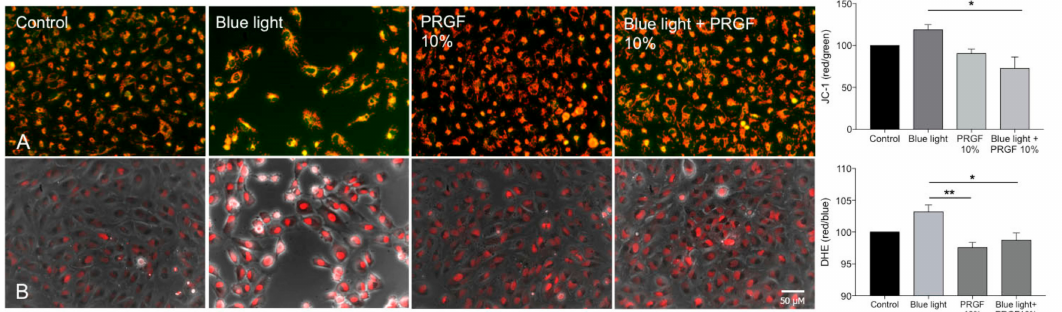
Figure 2. ARPE19 cell cultures ( n = 4). ( A ) JC-1 staining to study mitochondria status, PRGF enhances mitochondria status in presence of blue light; ( B ) Dihydroethidium staining (DHE) for the presence of reactive oxygen species (ROS), PRGF significantly reduces the expression of ROS as compared with the blue light treatment. Statistical analysis: One-way ANOVA, Tukey multiple comparison test, * p < 0.05, and ** p < 0.005. Scale = 50 µ